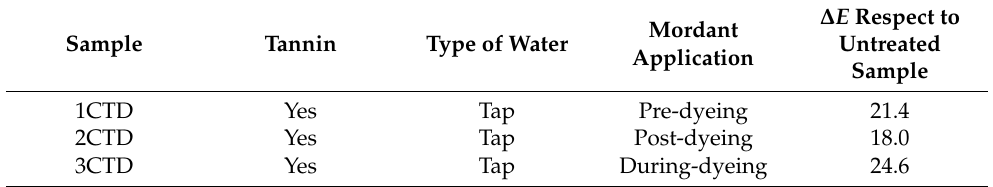
Figure 8. ( a ) Fabrics dyed with calendula with pre-mordanting, post-mordanting, and meta-mordanting (from left to right, respectively) and ( b ) K/S values of fabrics dyed with calendula with pre-mordanting, post-mordanting, and meta-mordanting. Table 11. Colorimetric values obtained for the samples dyed with calendula with tannin as the mordant.